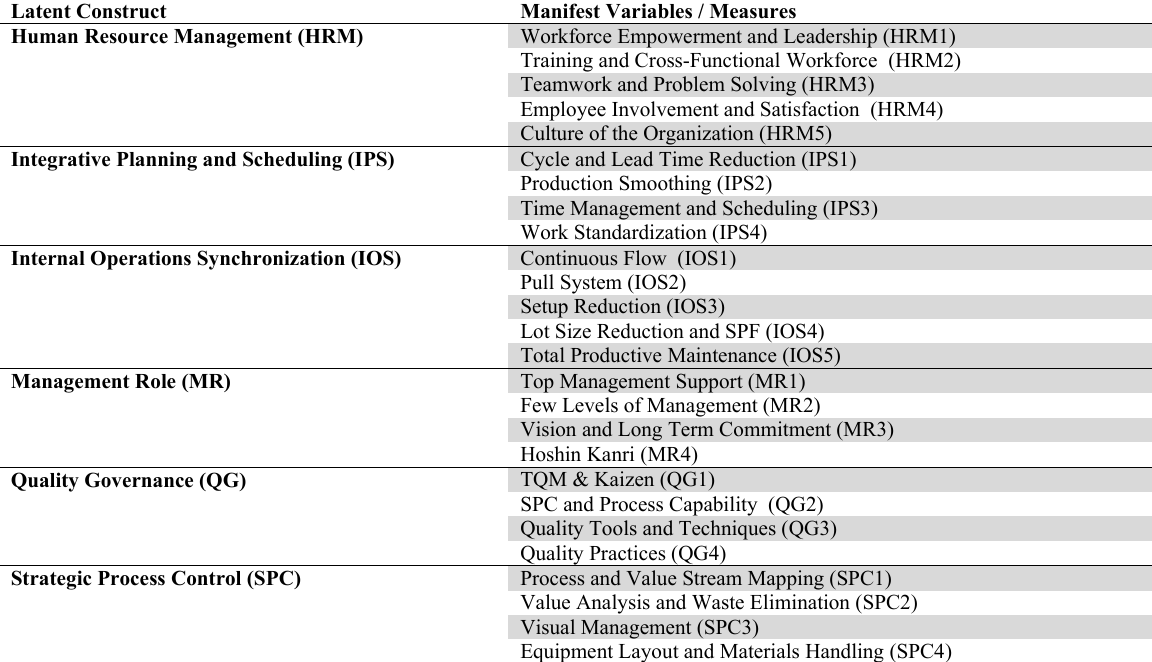
Input Manifests and Latent Constructs related to HR and internal practices for LM